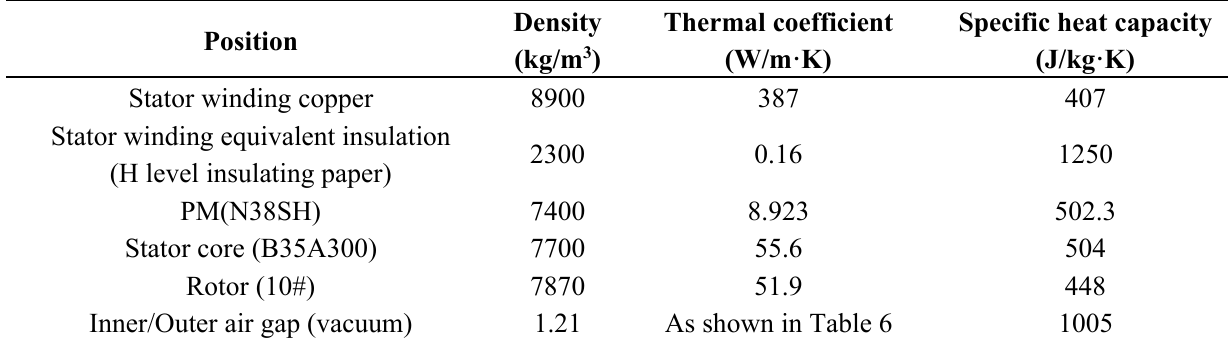
Table 7. Thermal parameter of motor